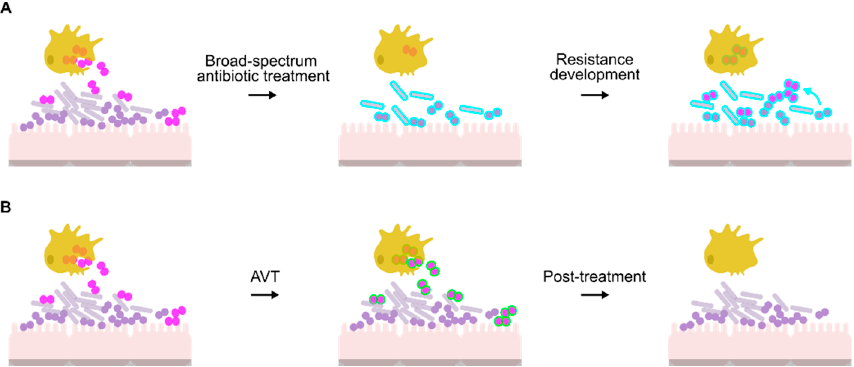
Figure 1. Comparison of antibiotic and anti-virulence approaches for treatment of N. gonorrhoeae . ( A ) Potential route for antibiotic resistance development in N. gonorrhoeae (pink diplococci). Antibi- otics also affect the microbiome ( Lactobacilli : grey rods; commensal Neisseria : purple circles), forcing resistance determinants to evolve (blue outline). This resistance can then develop in N. gonorrhoeae through gene acquisition via natural transformation (blue arrow) or spontaneous mutation. While antibiotic treatment may assist PMNs and macrophages (yellow cells) in killing the bacteria, the prescribed concentration may not be effective, resulting in proliferation of antibiotic resistant bacteria. ( B ) Use of AVTs (green outline) enables PMNs and macrophages to kill the gonococci without affecting the microbiome.